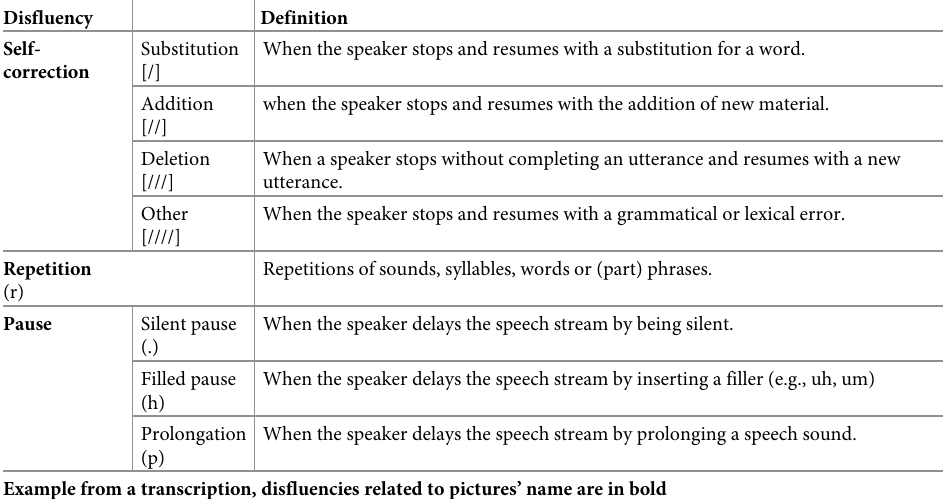
Table 2. Definitions of each disfluency and example from a translated transcription. Disfluencies that are taken into account in the analyses (i.e., preceding pictures) are in